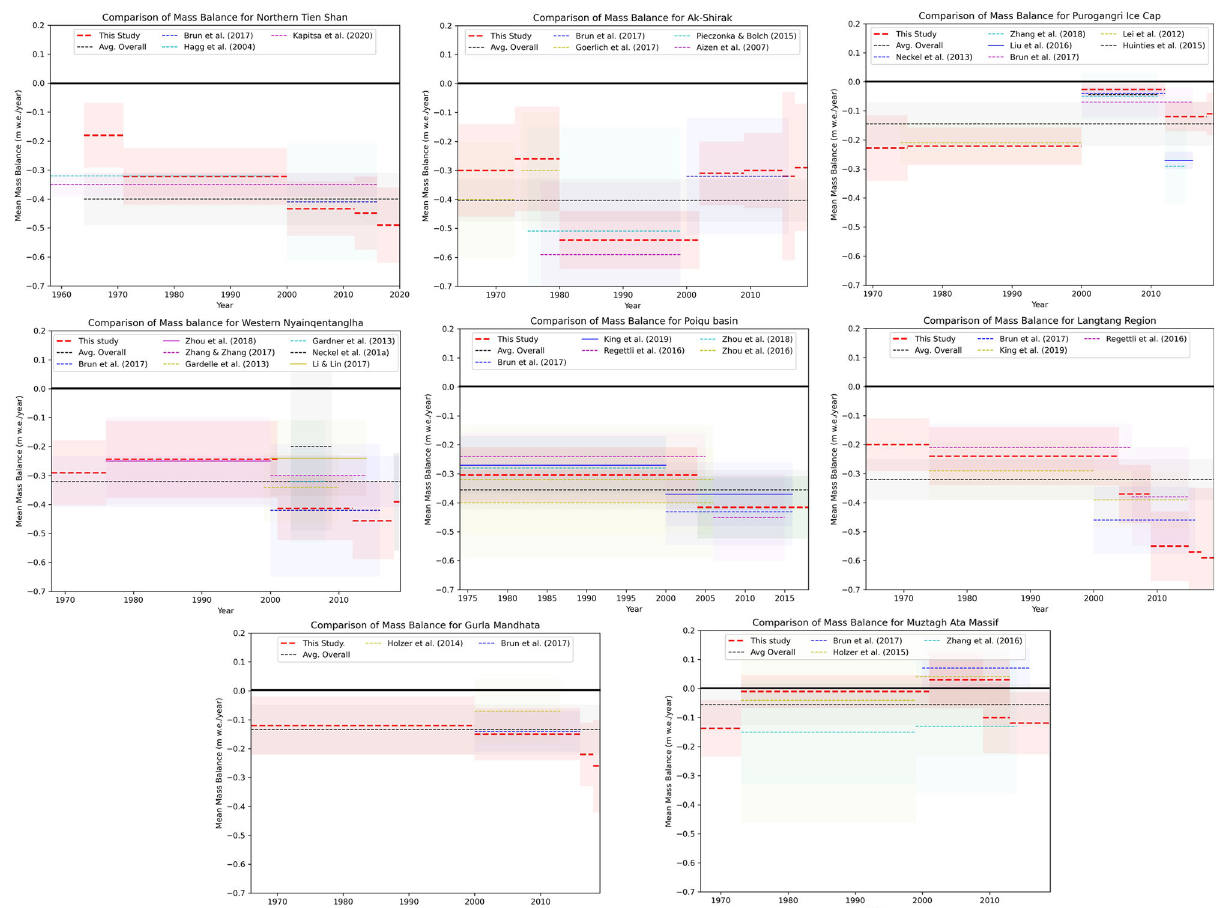
Fig. 3 Comparison of regional glacier mass balance with other published studies. Figure 3 indicates mean glacier mass balance (dotted lines) and associated uncertainty (light color rectangle). Considering the temporal and methodological variability, the regional mass balance pattern for the present study is in general consistent with the other available studies. Balanced mass budget periods appear to have ended in Muztag Ata, Gurla Mandhata, and Purogangri Ice Cap regions and the glaciers of these regions have lost mass